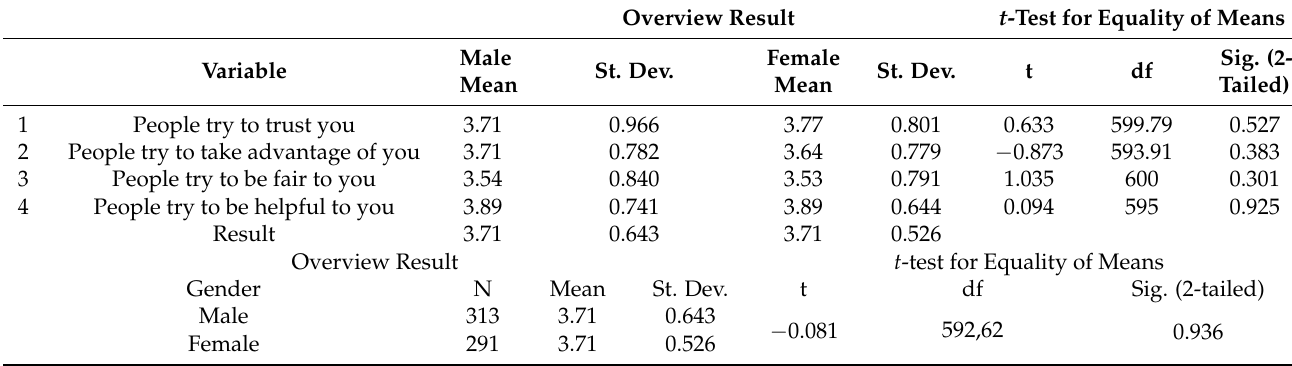
Table 5. Gender comparison: Social trust.